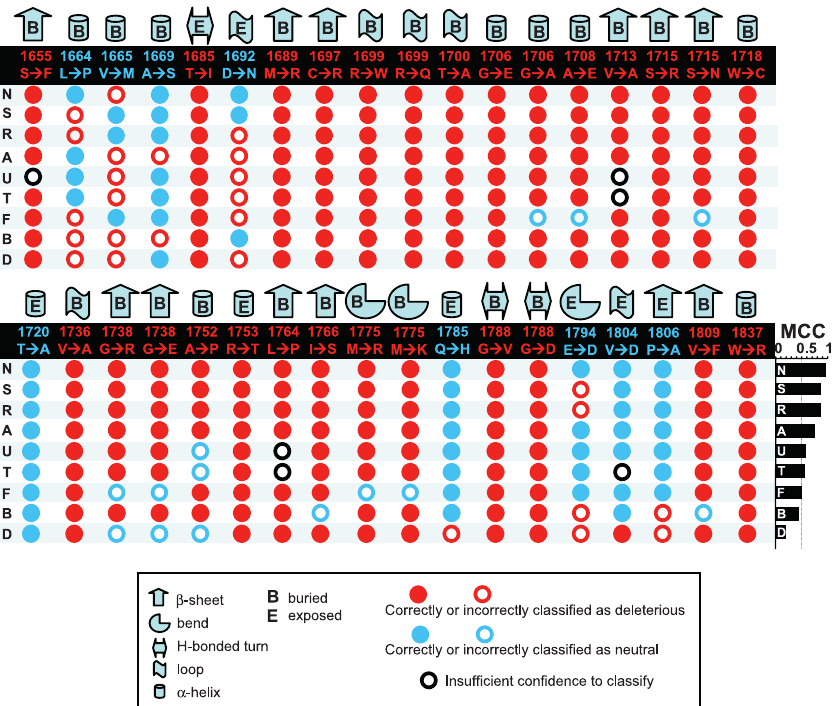
Figure 1. Computational Classifications of 36 BRCA1 BRCT Variants Functionally Characterized by the Transactivation Assay For each variant, the local protein structure environment is represented by secondary structure type and whether the amino acid residue is buried ( normalized solvent accessibility , 0.2 ) or exposed ( normalized solvent accessibility (cid:3) 0.2 ). Labels ( ‘‘ 1655 S- . F ’’ ) are colored according to whether the variant was functional in the assays (blue) or nonfunctional (red). Computational classifications in agreement with the assay are indicated by filled circles. Computational classifications not in agreement with the assay are indicated by outlined circles. Computational classifications yielding ‘‘ unclassified ’’ are indicated by an outlined black circle. The variant D1692N is fully functional as a transcriptional activator but results in incorrect splicing in vivo. Results from variant M1775K are unpublished (Foulkes et al.). A, Ancestral Sequence; B, Rule-based decision tree; D, Decision Tree; F, SIFT; MCC, Matthews correlation coefficient; N, Naı¨ve Bayes; R, Random Forest; S, Support Vector Machine; T, Align-GVGD Tnig; U, Align-GVGD